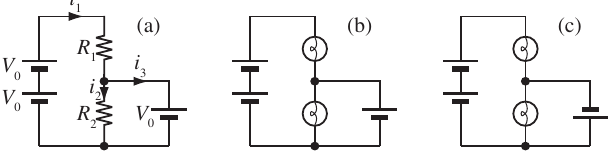
FIG. 1. Circuits with multiple batteries in multiple loops. Standard methods can be used to solve problems with linear resistors like (a), but fail to deal with nonlinear resistors as in circuits (b) and